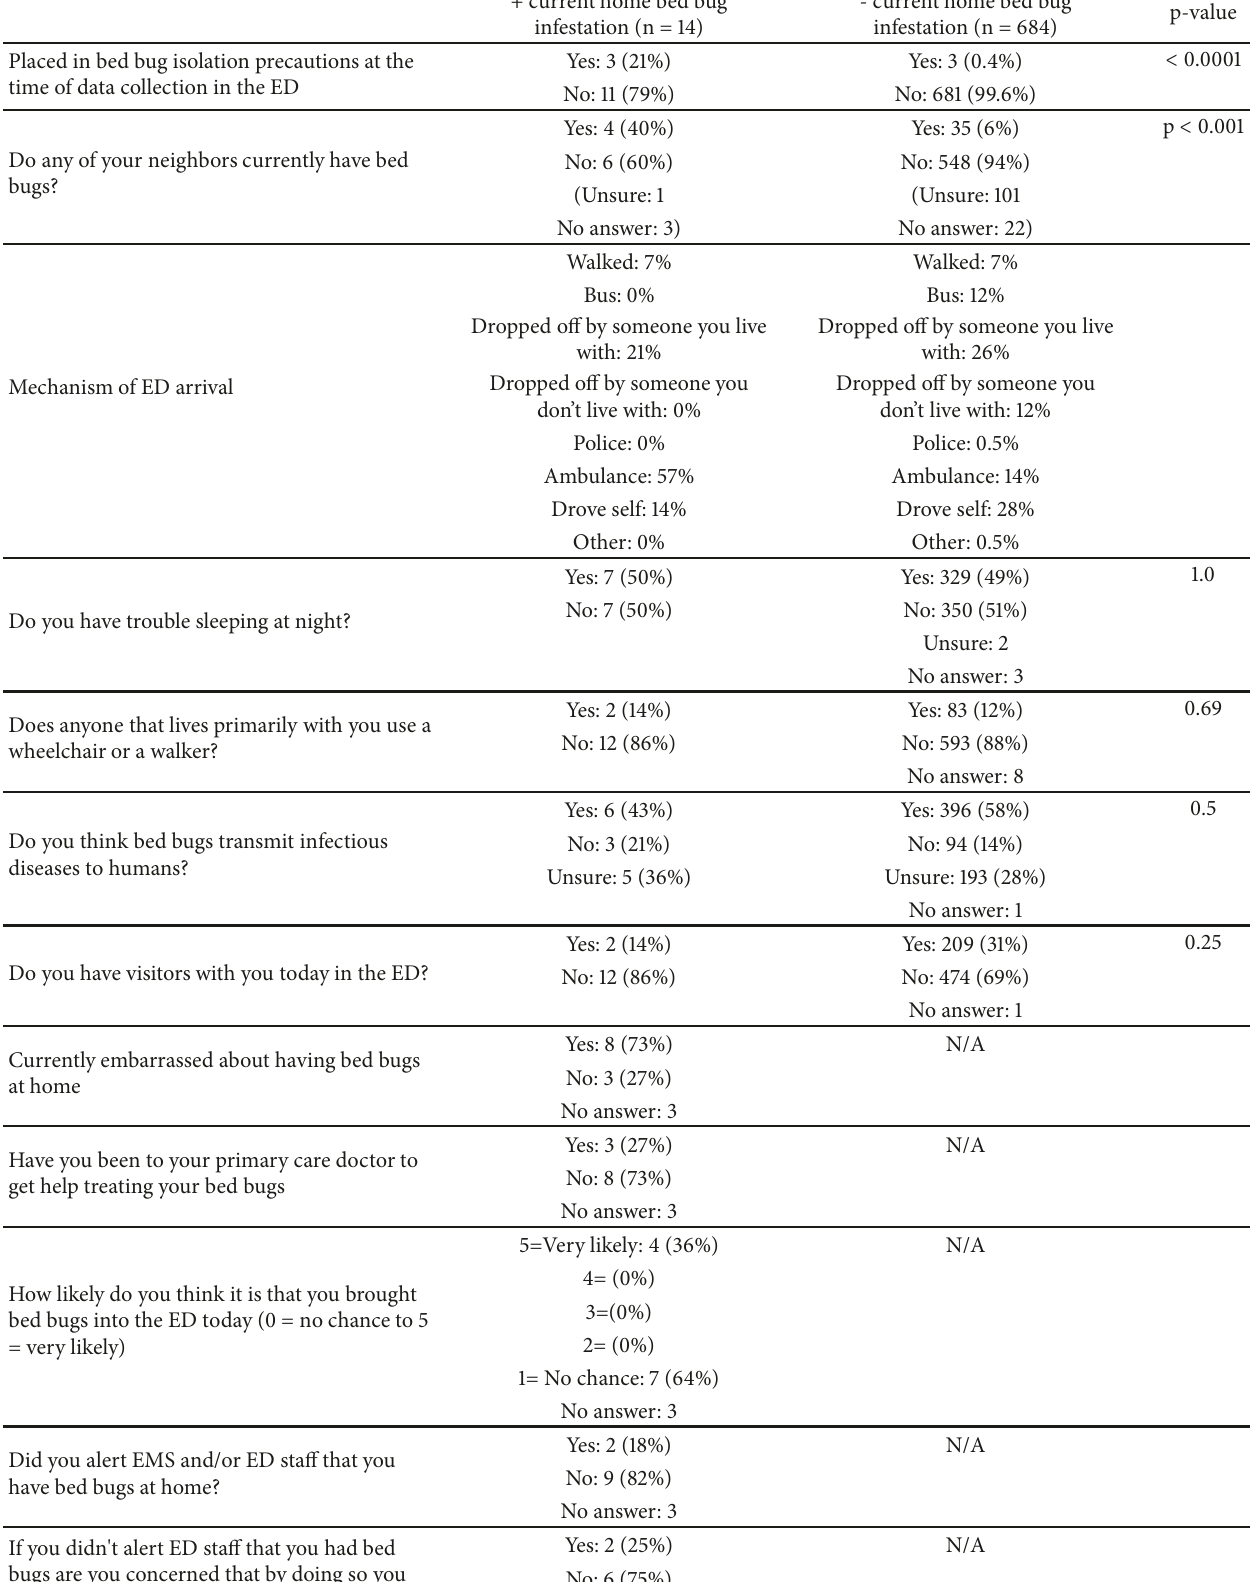
Table 1: Survey results comparing those with and without an active home bed bug